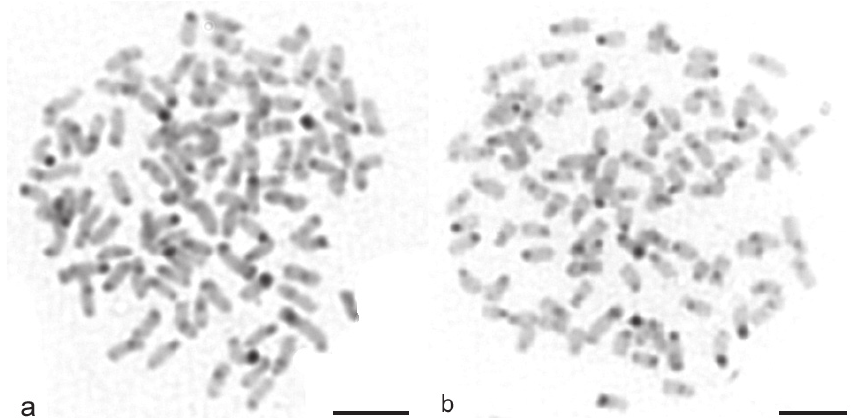
Figure 4. a–b C-banded metaphases of C . carassius female ( a, b ) show signals localized in the teloce- meric and pericentromeric chromosome regions. Bar = 10 μm.